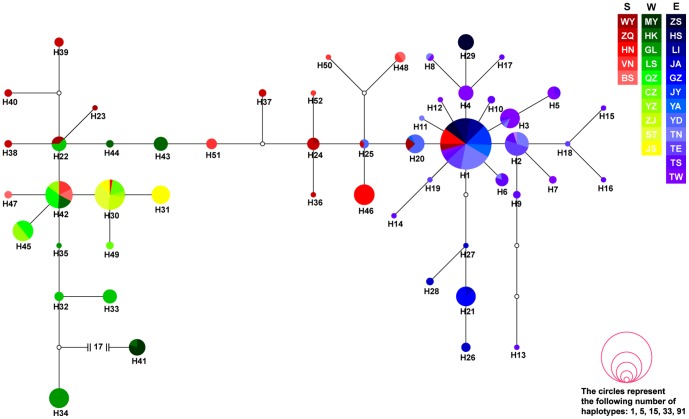
Network of 52 mitochondrial control region haplotypes from 390 individuals of Naja atra.The size of the circles is proportional to haplotype frequency; small open circles represent unsampled haplotypes. See Table 1 for sample site abbreviations.